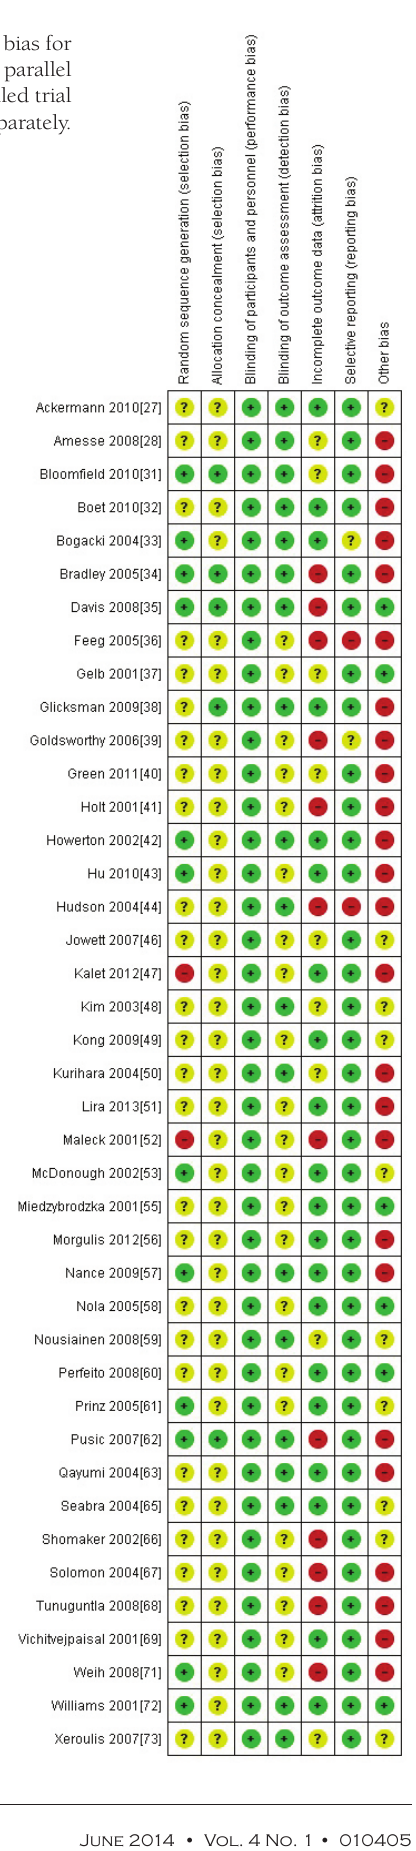
Figure 4. Risk of bias for each individual parallel randomised controlled trial (RCT)